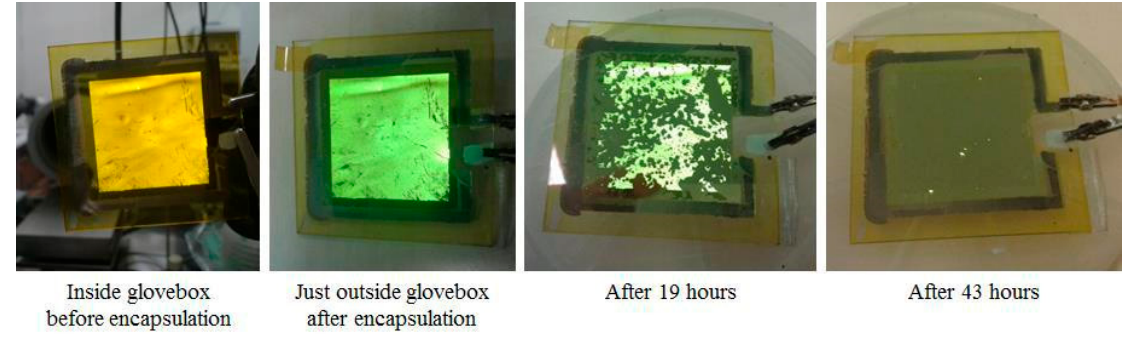
Figure 6. The OLED (organic light emitting diodes) after before and after encapsulation showing a fast degradation with full fading after only 43 h.